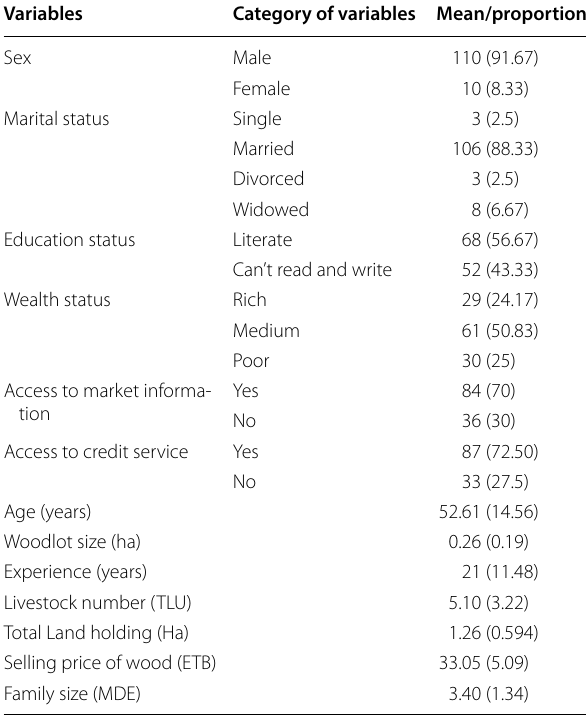
Household survey data (2017); Figures in parenthesis represent % and std. dev